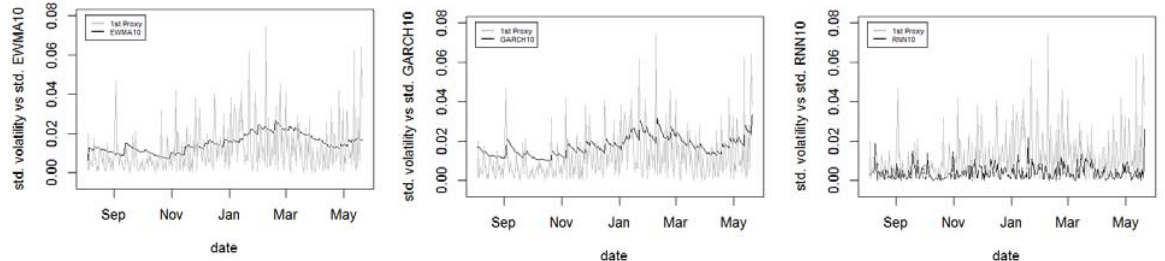
Figure A3. Out of sample standard deviation of realized volatility (1st proxy) vs. standard deviation of 10 days ahead Figure 3 . Out of sample standard deviation of realized volatility (1st proxy) vs standard deviation of 10 days volatility forecasting of EWMA, GARCH and RNN model. ahead volatility forecasting of EWMA, GARCH and RNN model